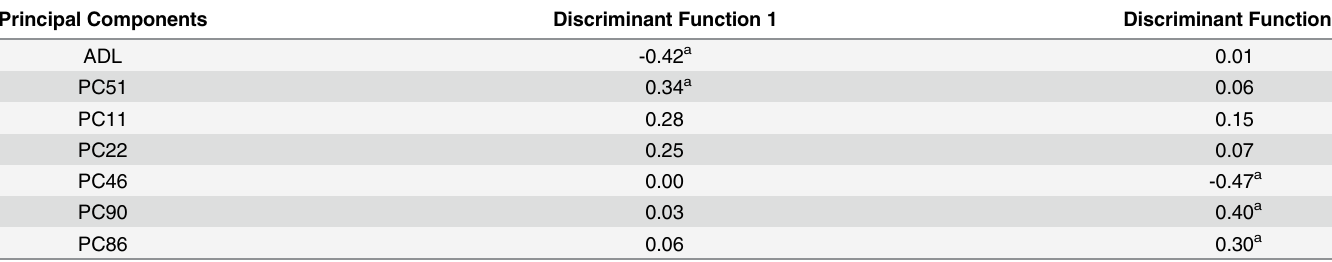
Table 3. Structure matrix of correlations between predictor variables and discriminant